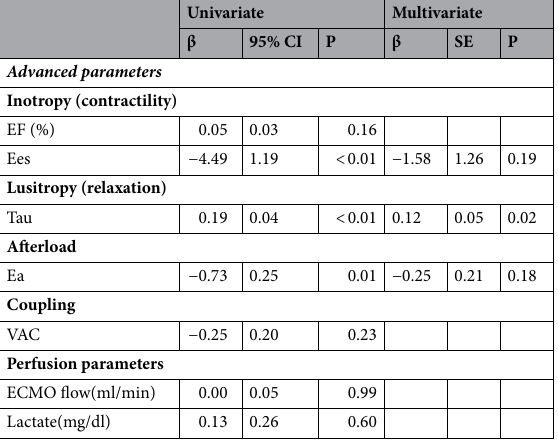
Table 4. Regression for PVA to other PV loop-derived advanced parameters and perfusion parameters in the 14 septic rats on ECMO. Ea arterial elastance, EDV end-diastolic volume, Ees end-systolic elastance, EF ejection fraction, ESV end-systolic volume, PE potential energy, PVA pressure–volume area, SW stroke